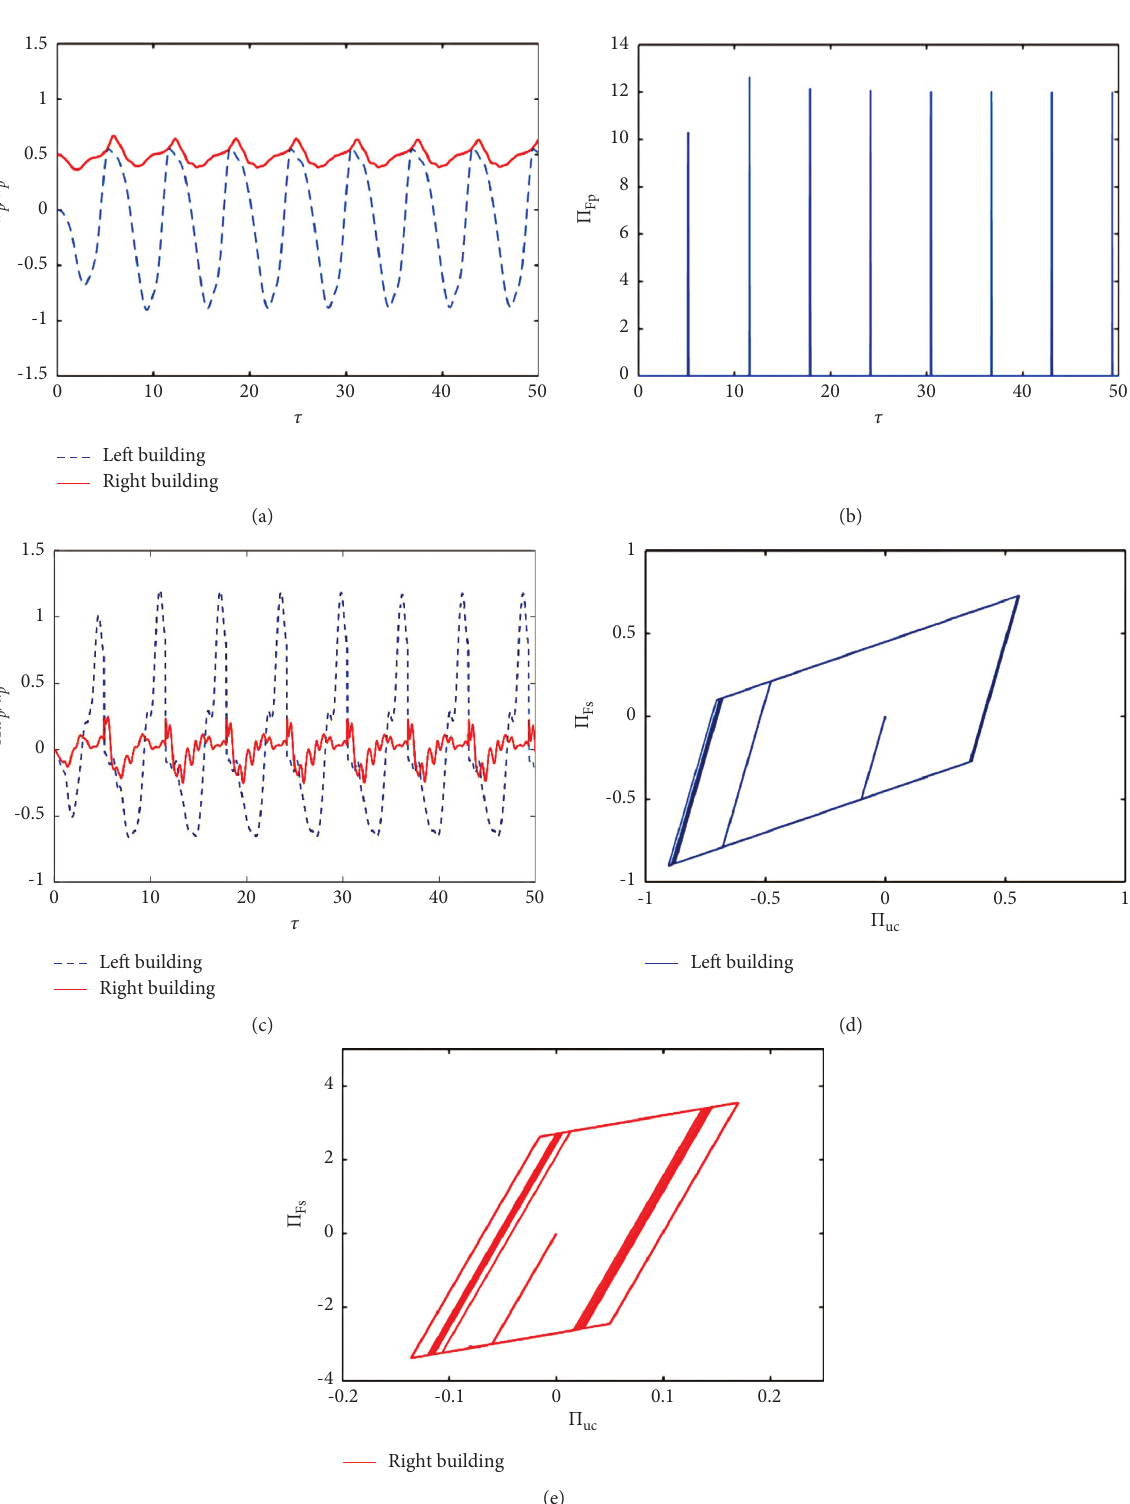
Figure 3: Displacement, velocity, pounding force histories, and hysteresis curves for the first story of adjacent buildings. (a) Displacement histories. (b) Pounding force histories. (c) Velocity histories. (d) Hysteresis curve of the left structure. (e) Hysteresis curve of the right